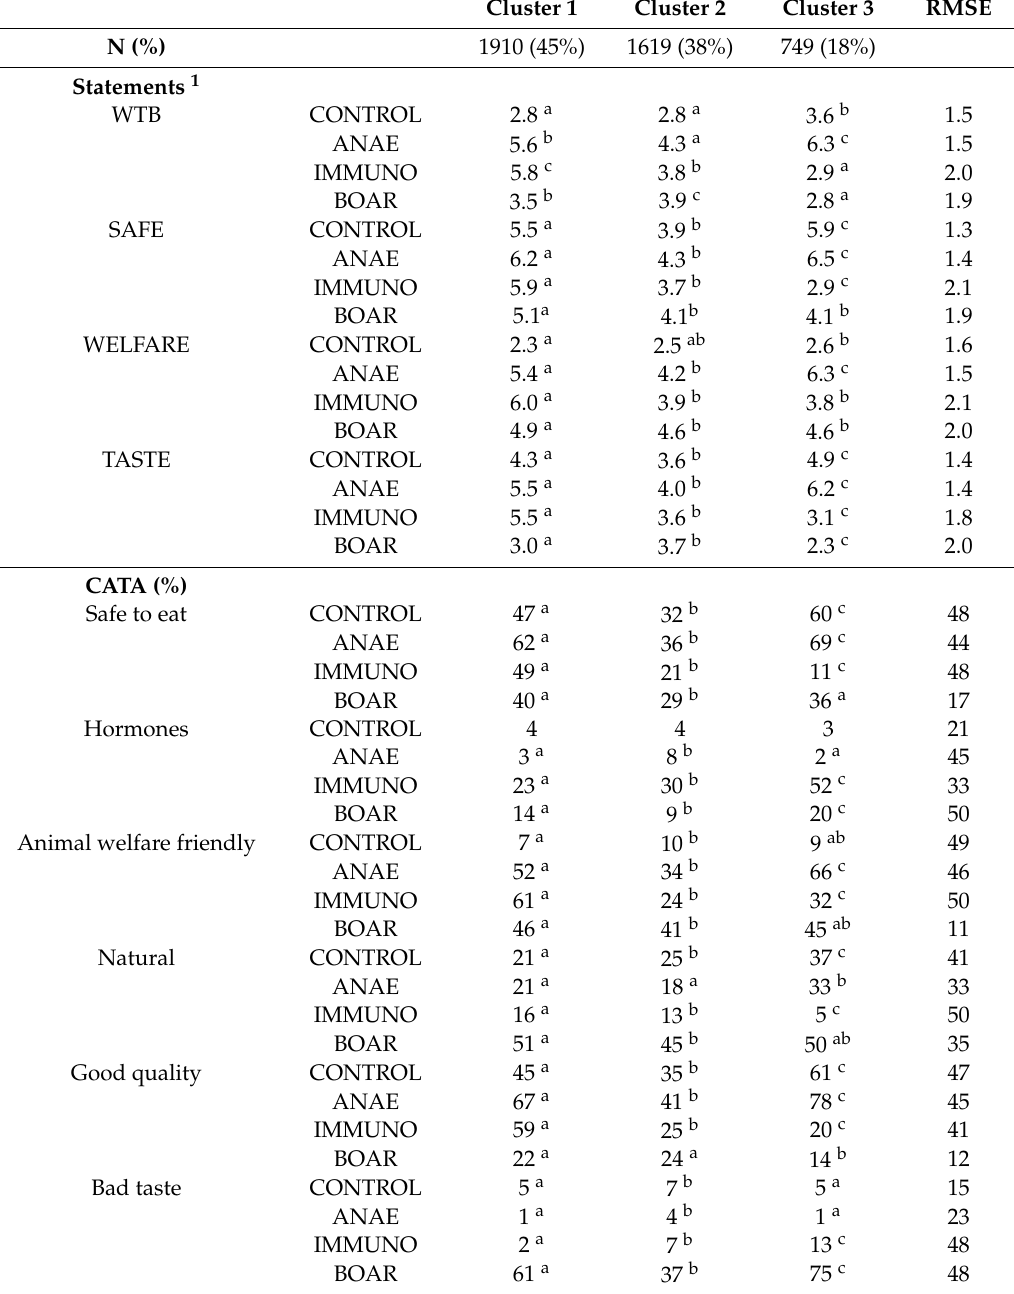
Table 4. Comparison of the statements and CATA scoring over clusters for all respondents and all non-professionally involved respondents of the di ff erent options (Castration without pain relief—CONTROL, castration with anaesthesia—ANAE, Immunocastration—IMMUNO, and no